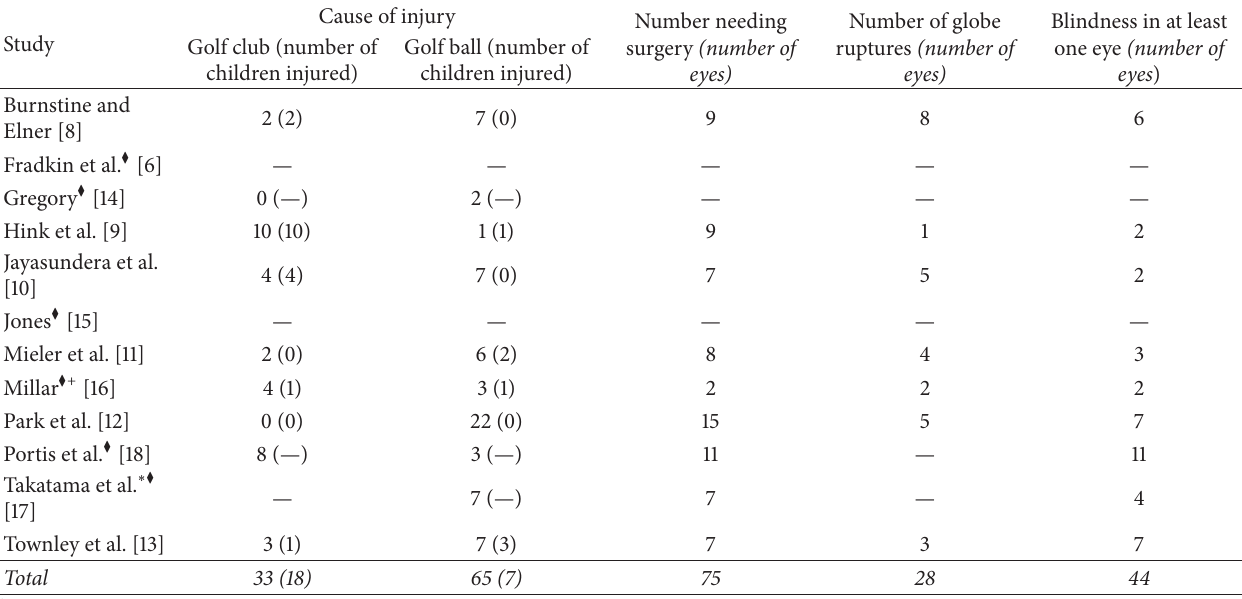
Table 3: Consequences of golf-related ocular